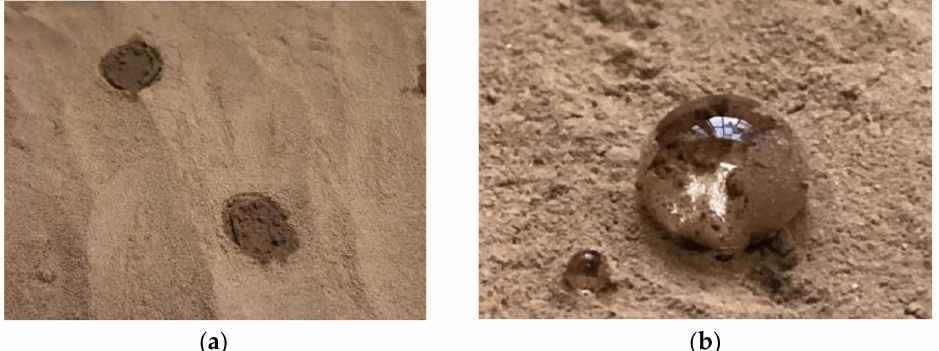
Figure 10. Water droplets on the surface of different soil samples: ( a ) Water droplets on the surface of original soil sample; ( b ) Water droplets on the surface of Sample